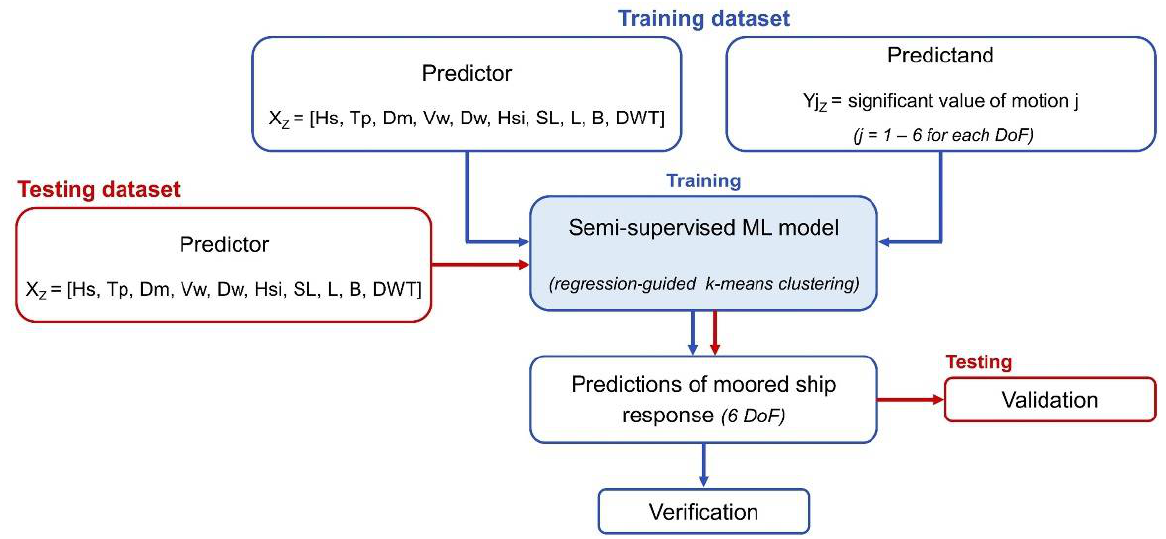
Figure 2. General flowchart of the methodology: Training and testing phases.